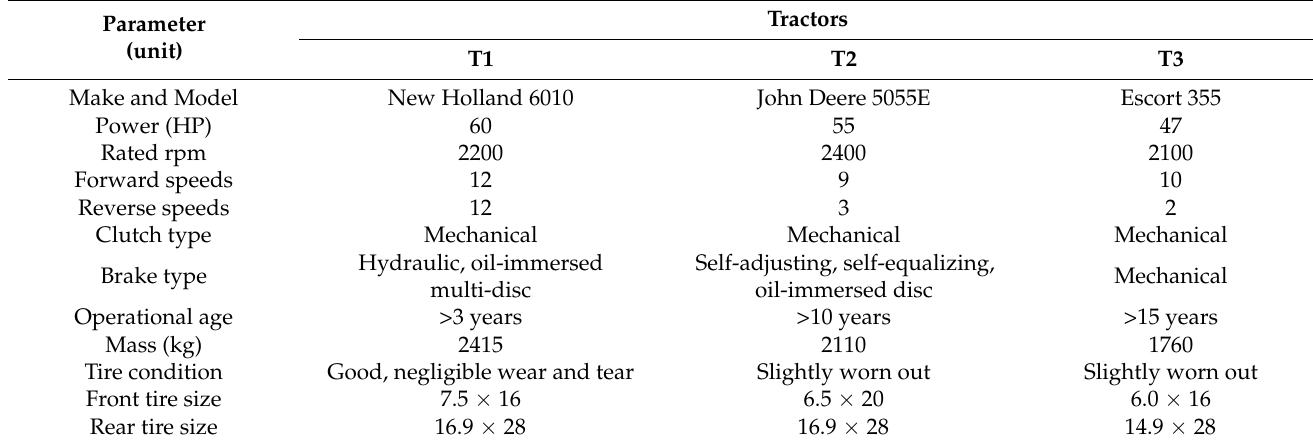
Table 1. Specifications of the selected tractors in the